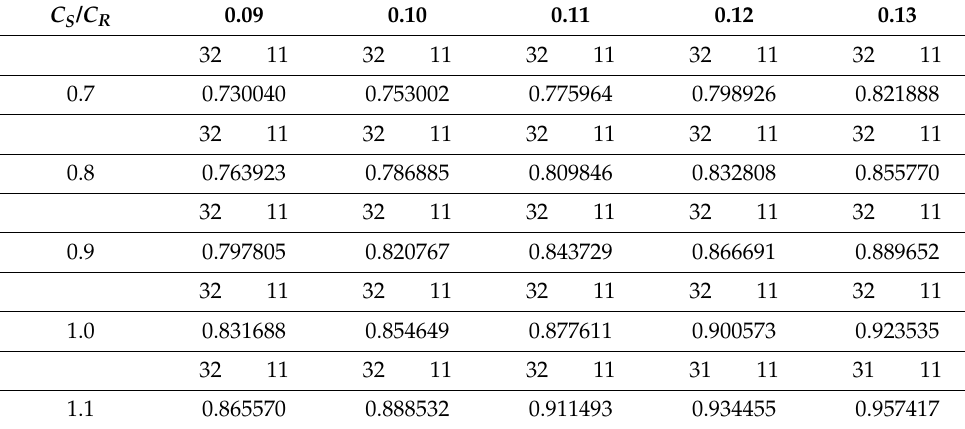
Table 9. Impact of C S and C R costs on the optimal